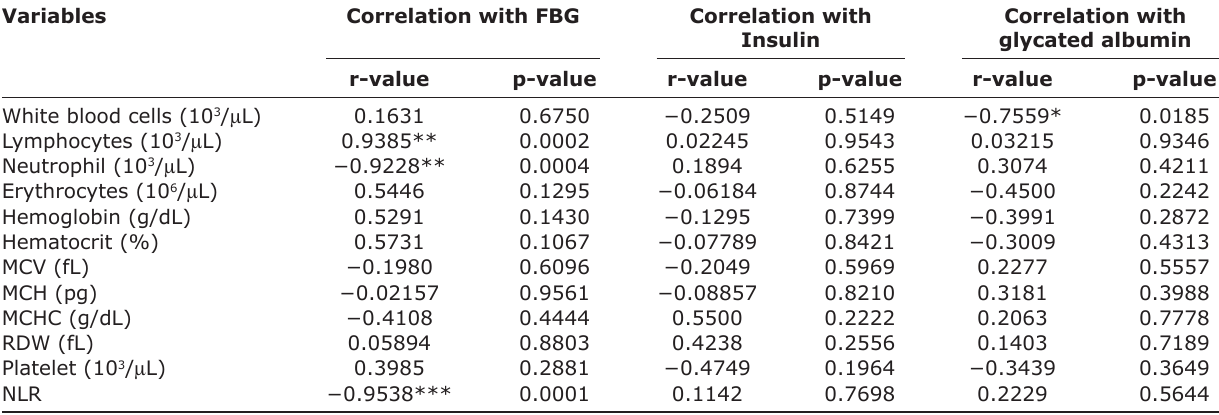
Table-4: Correlation of FBG, insulin, and glycated albumin with hematological parameters in prediabetic rats. Variables Correlation with FBG